Question: According to the figure, is the described quantity increasing or decreasing?
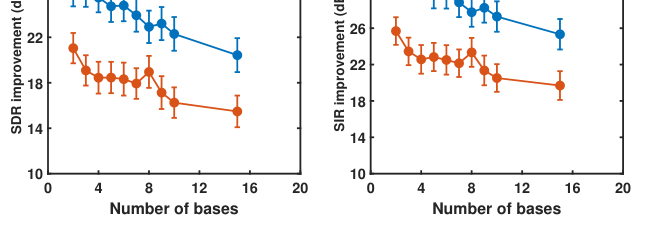
Answer: increasing